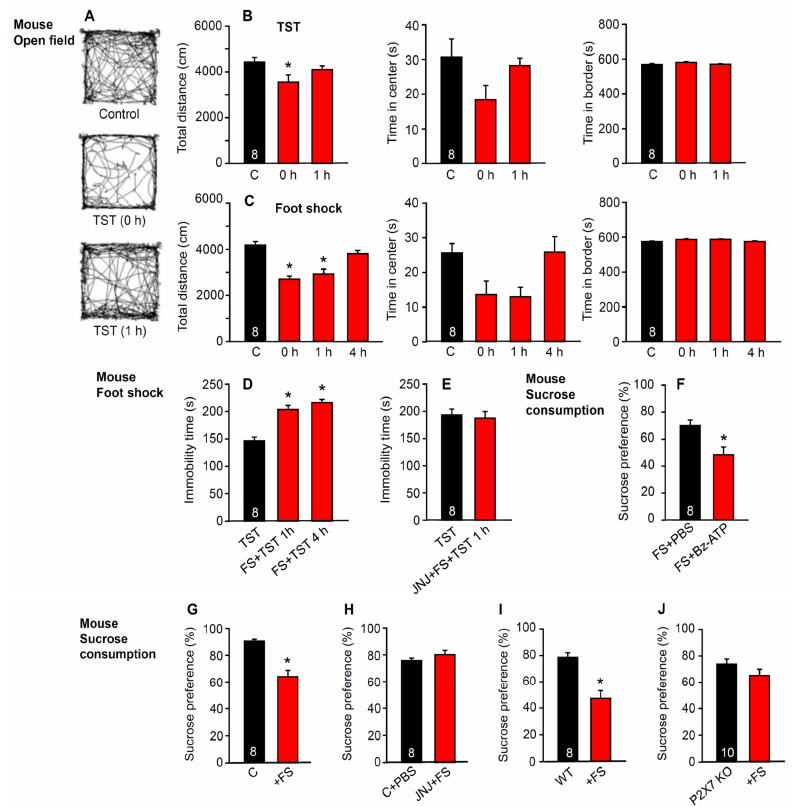
Figure 2. Effects of the TST and foot shock on the open-field behavior of mice; changes in the TST immobility time and sucrose consumption after foot shock and its antagonism by the blockade or genetic deletion of the P2X7Rs. ( A ) running traces of mice in the open-field apparatus under control conditions, immediately after TST, and 1 h after TST. The observation time was 10 min. ( B ) total running distance, time spent in the center, and time spent in the border of the open-field apparatus without TST (control), as well as immediately (0 h) and 1 h after TST. ( C ) total running distance, time spent in the center, and time spent in the border of the open-field apparatus without TST, as well as immediately (0 h), 1 h, and 4 h after foot shock. * p < 0.05; statistically significant difference from the three open-field parameters measured without the application of TST or foot shock ( B , Total distance, F = 3.526, 0 h, p = 0.046; C , Total distance, F = 19.412, 0 h, p < 0.001, 1 h, p < 0.001) one-way ANOVA, followed by the Holm–Sidak test. ( D ) the TST immobility time measured without foot shock, or alternatively 1 or 4 h after foot shock. ( E ) the TST immobility time measured without foot shock or after the co-application of JNJ-47965567 (30 mg/kg; i.p.) and foot shock. * p < 0.05; statistically significant differences from the TST immobility time alone ( D , FS + TST, F = 29.415, 1 h, p < 0.001, 4 h, p < 001; one-way ANOVA, followed by the Holm–Sidak test). Effect of i.c.v. Bz-ATP (10 µ M) on the foot shock-induced modulation of sucrose preference when compared with the effect of the solvent PBS alone ( F ). Change in sucrose preference after foot shock ( G ) and the inhibition of this effect by JNJ-47965567 (30 mg/kg; i.p.) ( H ). In control experiments the solvent of JNJ-47965567 was applied before the foot shock (FS). The change in sucrose preference after foot shock ( I ) and no effect on the P2X7R KO animals ( J ). * p < 0.05; statistically significant difference from sucrose consumption after FS + PBS ( F , FS + Bz-ATP, t = 3.102, p = 0.008) or untreated controls ( G , t = 5.404, p < 0.001; I , t = 2.531, p = 0.024); Student’s t -test. The number of experiments is indicated in the first column of each